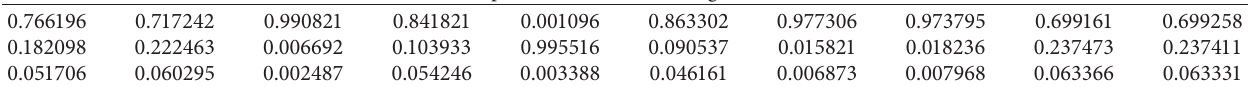
Table 2: The membership results of the FCM algorithm on the Wine data set.